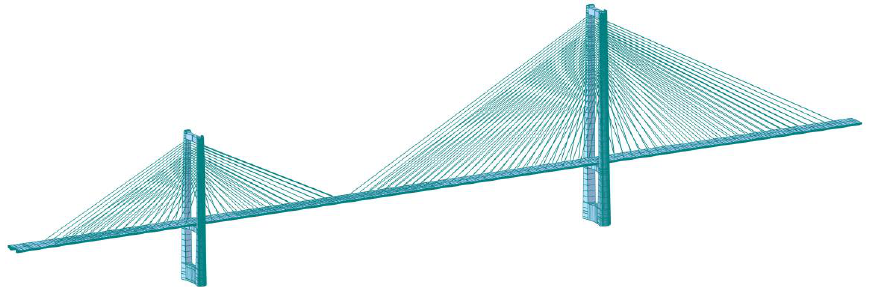
Figure 5. The FEM numerical analysis model of the Nanjimen Yangtze River Track Special